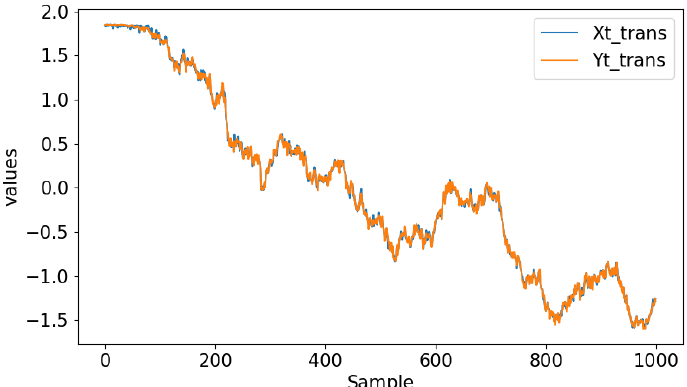
Figure 4. Two-dimensional transformed data.